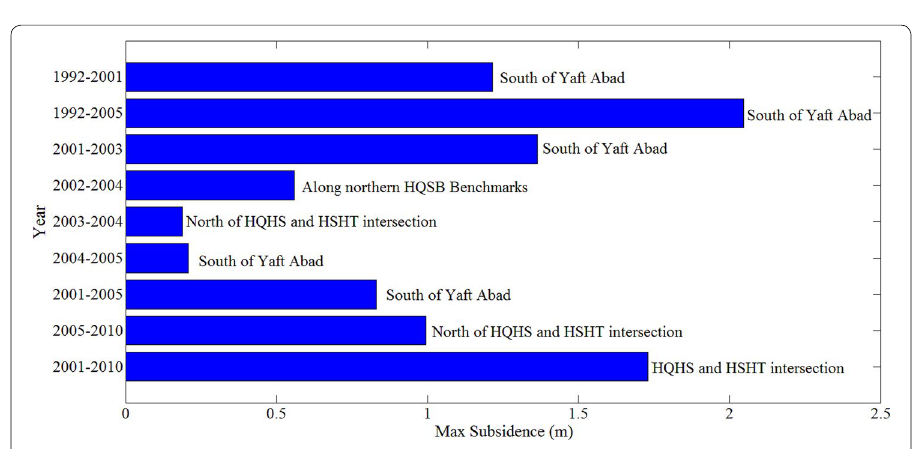
Fig. 10 Maximum measured land subsidence in different